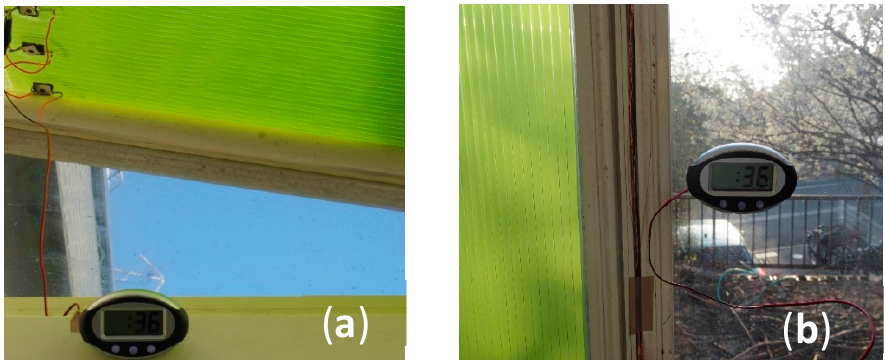
Figure 7. Photograph for the driving of the digital clock by the PSII roof ( a ) and PSII window ( b ).